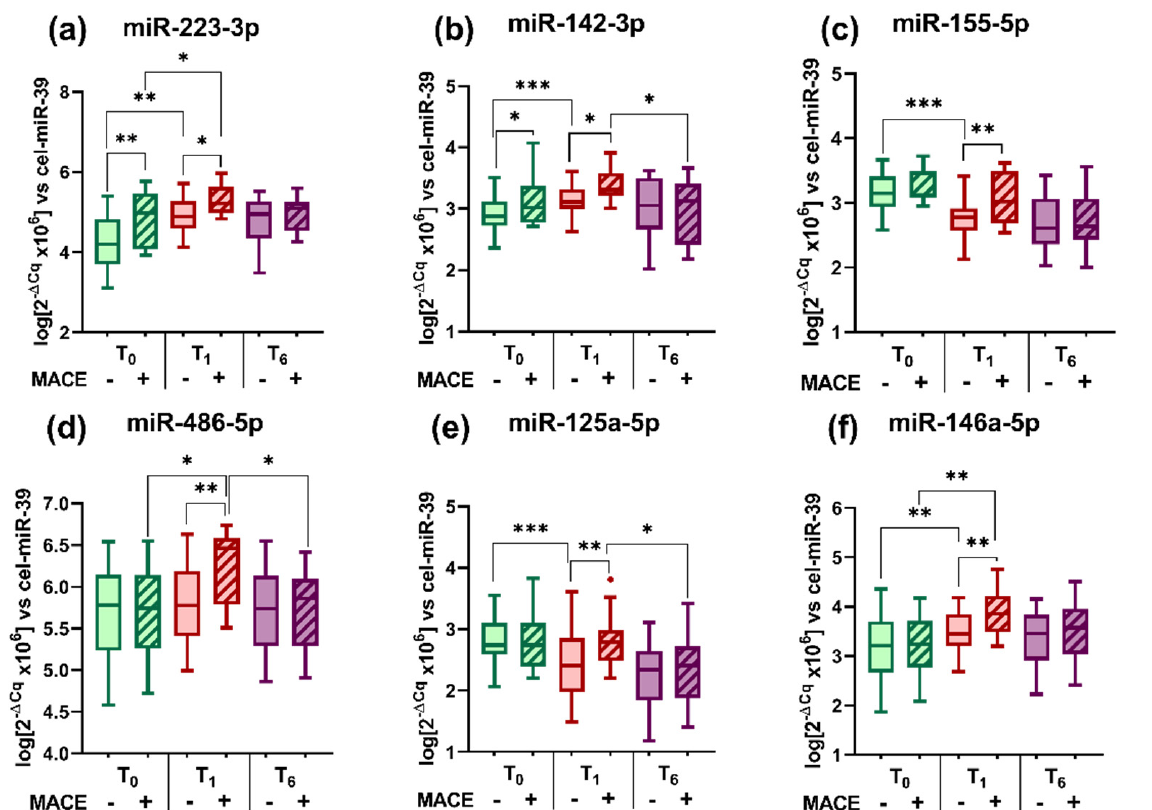
Figure 5. Variation of miRNA ( a – f ) levels in the plasma of ST-segment elevation myocardial infarction (STEMI) patients at T 0 , T 1 , and T 6 time points grouped by the occurrence of subsequent major adverse cardiovascular events (MACE) at 6-month follow-up. Data are illustrated as boxplots with Tukey whiskers and median line; the “-” symbol signifies the respective STEMI group without MACE, while the “+” symbol signifies the respective STEMI group with MACE. * p < 0.05, ** p < 0.01, *** p < 0.001.